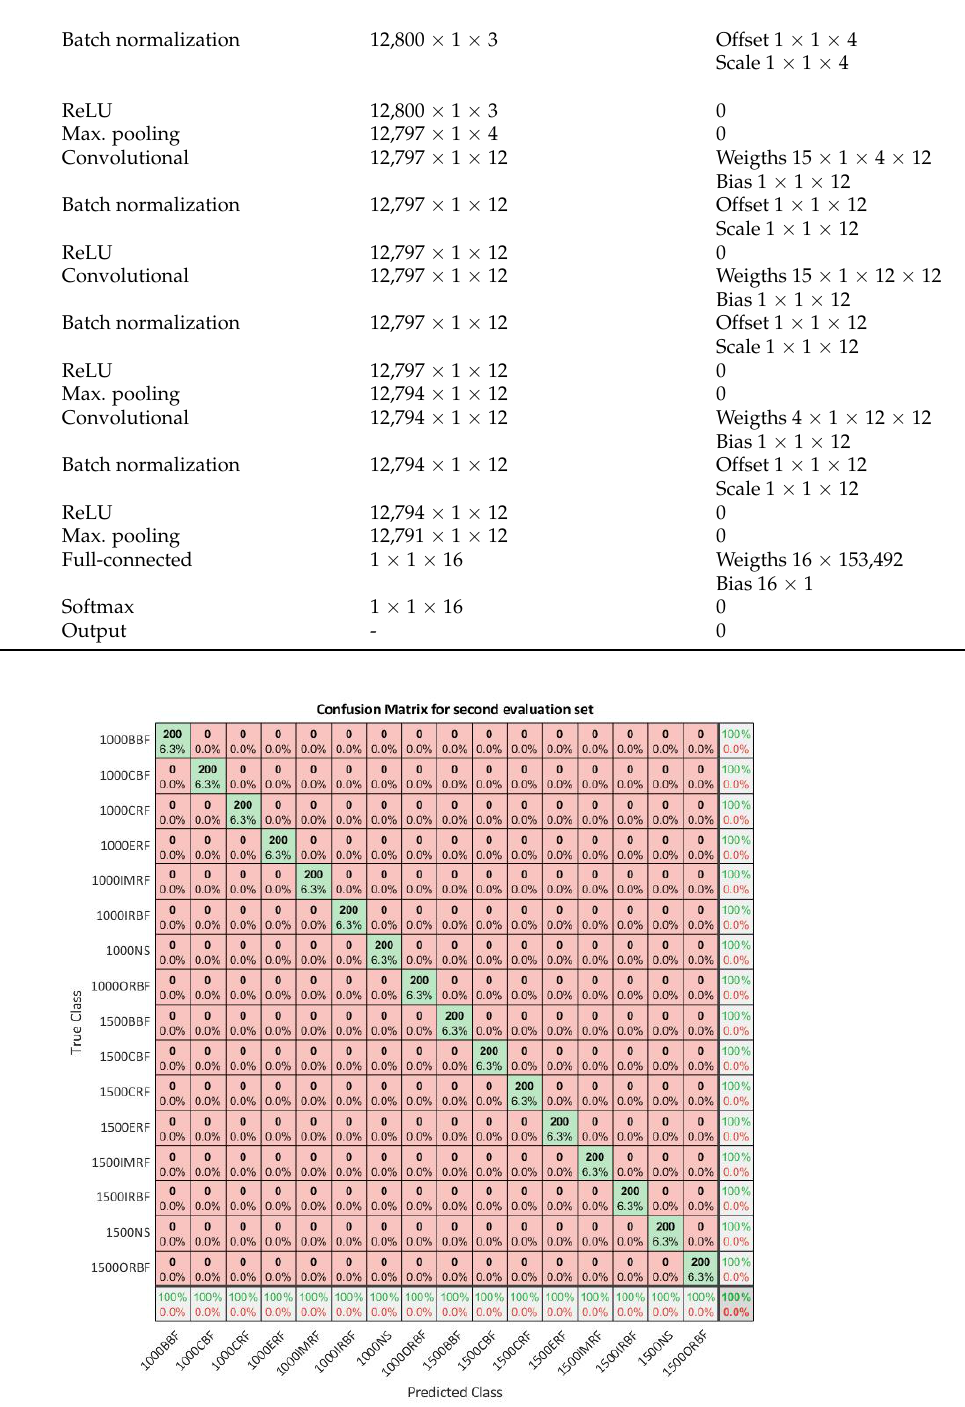
Figure 8. The confusion matrix for 16 predicted classes across the true class with second evaluation